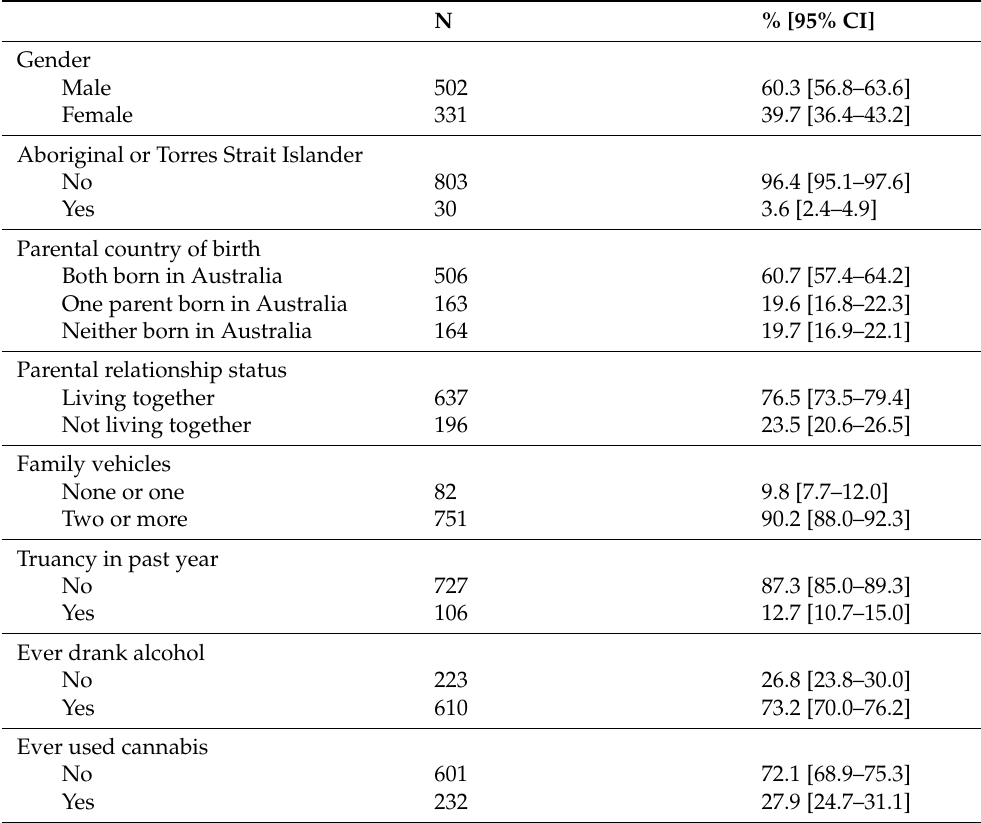
Table 1. Characteristics of Grade 12s of 2020 (N = 833; mean age = 17.2 [17.1–17.2]).